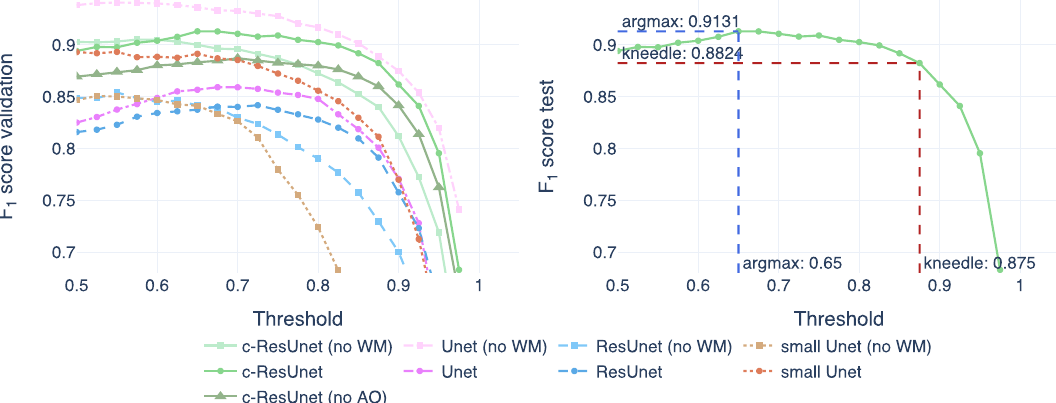
Figure 5. Threshold optimization. On the left, the F 1 score computed on validation images as a function of the cutoff for thresholding. On the right, the test F 1 score of the c-ResUnet model is used to illustrate the selection of the best threshold for binarization according to argmax (blue) and kneedle (red)